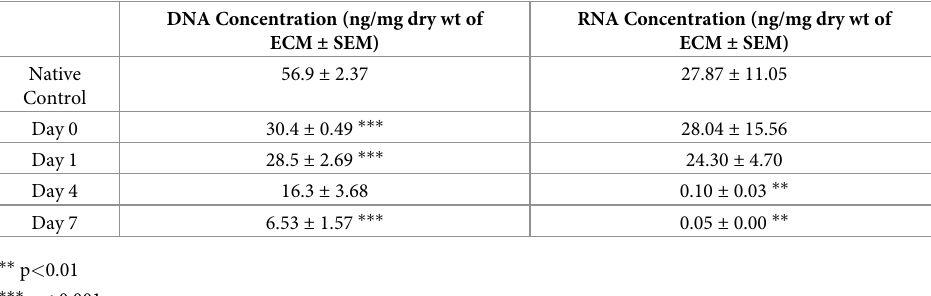
Table 2. Nucleic acid quantification. Quantification of residual DNA/RNA content in DCC scaffolds after one week of DNase/RNase treatment compared to native control bone. The total DNA/RNA content of the processed demineral- ized and decellularized bovine bone samples on different treatment days (days 1, 4 and 7) is shown in comparison to day 0 of the treatment period with statistical